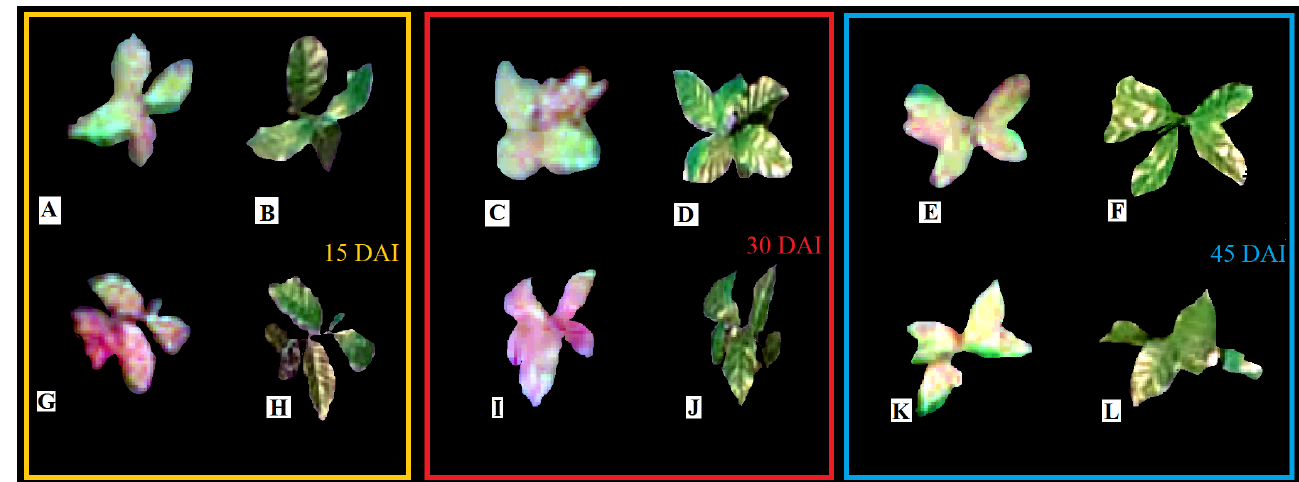
Figure 3. Coffee seedlings 15, 30, and 45 d after inoculation (DAI). Image of non-inoculated seedlings obtained by a Mapir Survey3W camera (red, green, and near infrared bands) at 15 DAI ( A ), non-inoculated seedlings in an RGB image at 15 DAI ( B ), inoculated seedlings at 15 DAI ( G ), inoculated seedling in an RGB image at 15 DAI ( H ), non-inoculated seedlings at 30 DAI ( C ), non-inoculated seedling in an RGB image at 30 DAI ( D ), inoculated seedlings at 30 DAI ( I ), inoculated seedlings in an RGB image at 30 DAI ( J ), non-inoculated seedlings at 45 DAI ( E ), non-inoculated seedlings in an RGB image at 45 DAI ( F ), inoculated seedlings at 45 DAI ( K ), and inoculated seedling in an RGB image at 45 DAI ( L ).